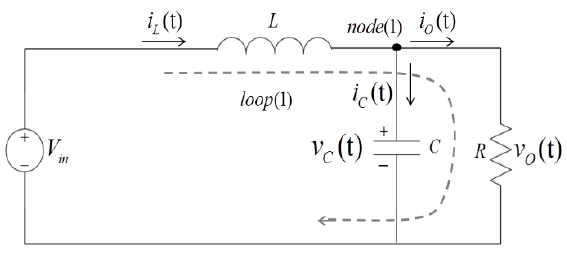
Figure 3. Switch-on mode circuit.